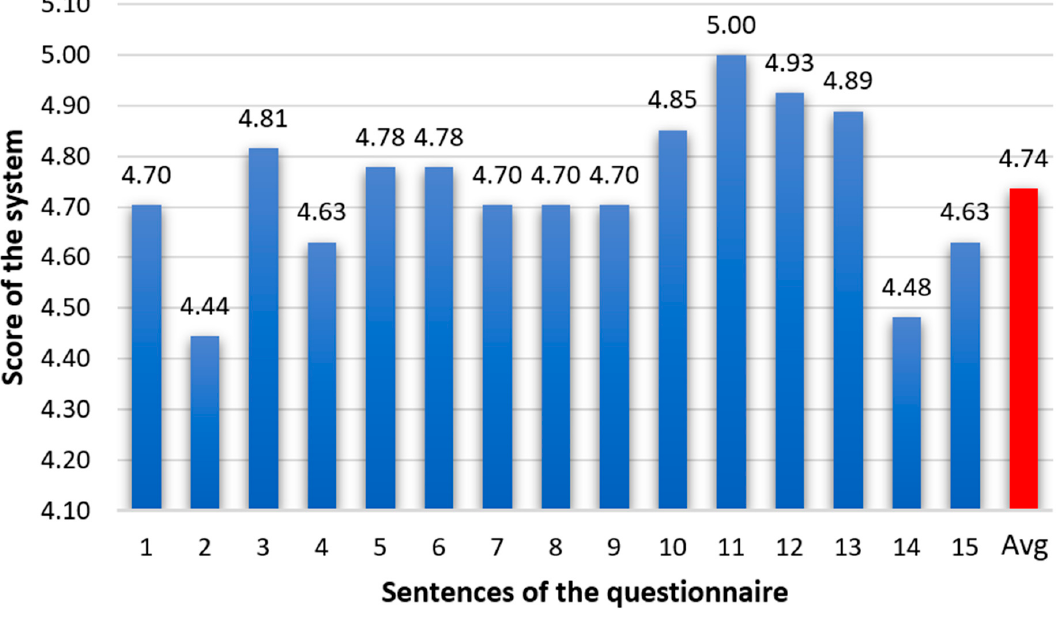
Figure 23. Testing scores obtained by the proposed system at “Dr. C.I. Parhon” Clinical Hospital of Ia ş i, Romania.